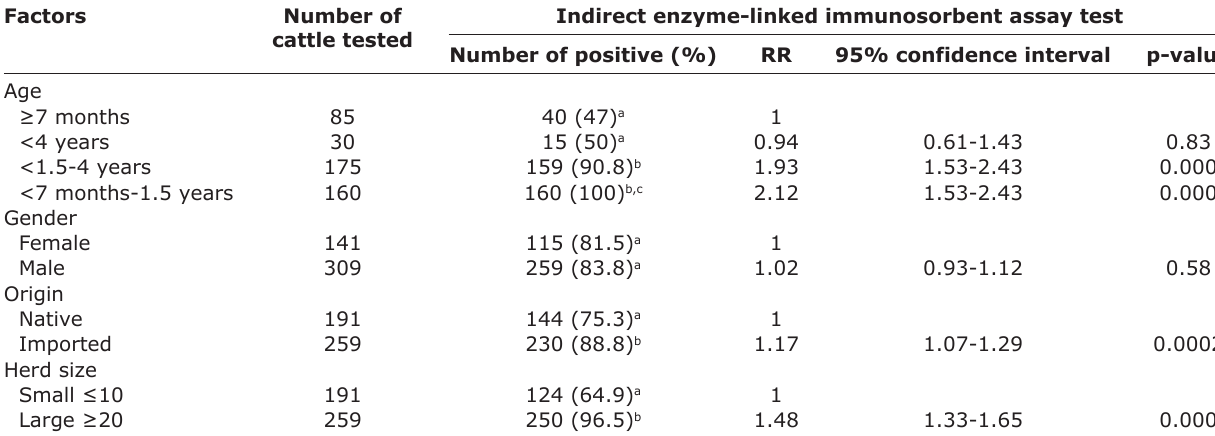
Table-1: Relative risk factors associated with the prevalence of bovine respiratory syncytial virus in cattle.